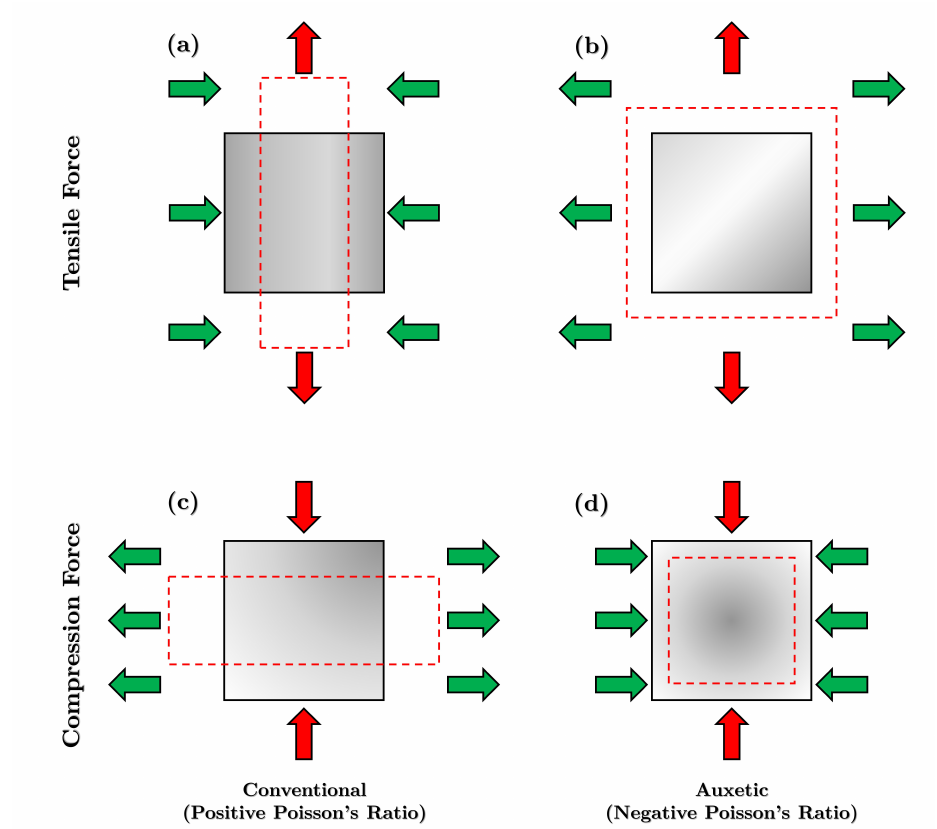
Figure 3. Comparison of the mechanical behavior of conventional and auxetic materials under tensile and compressive forces: ( a ) Tensile forces acting on a conventional material; ( b ) Tensile forces acting on an auxetic material; ( c ) Compressive forces acting on a conventional material; ( d ) Compressive forces acting on an auxetic material.